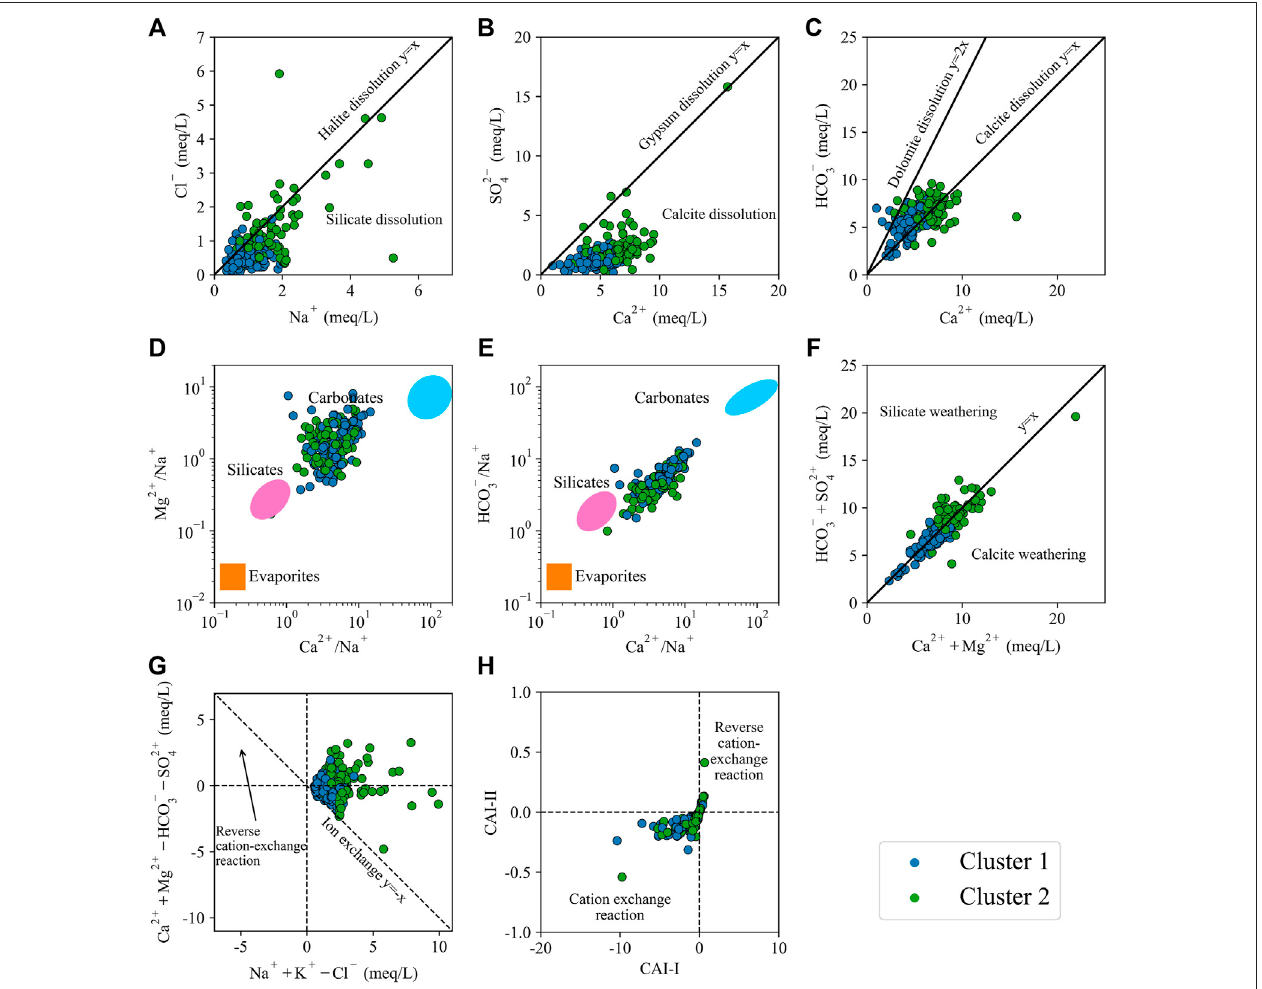
FIGURE 8 | Correlation graph of ions. (A) Cl − vs . Na + . (B) SO 42 − vs . Ca 2+ . (C) HCO 3 − vs . Ca 2+ . (D) Mg 2+ /Na + vs . Ca 2+ /Na + . (E) HCO 3 − /Na + vs . Ca 2+ /Na + . (F) HCO 3 − +SO 42 − vs .Ca 2+ +Mg 2+ . (G) [(Ca 2+ +Mg 2+ − HCO 3 − − SO 42 − ) vs .(Na + +K + − Cl − )]. (H) CAI-II[(Cl − − Na + K + )/(HCO 3 − +CO 2 − 3 +SO 42 − +NO − 3 )] vs .CAI-I[(Cl − − Na + − K + )/(Cl −